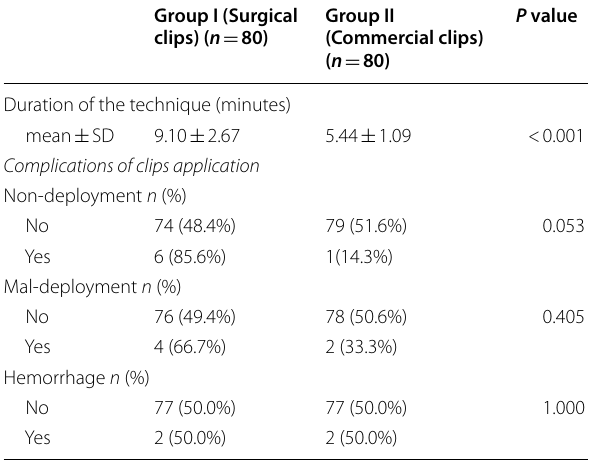
Table 2 Comparison between the two groups regarding duration and complications